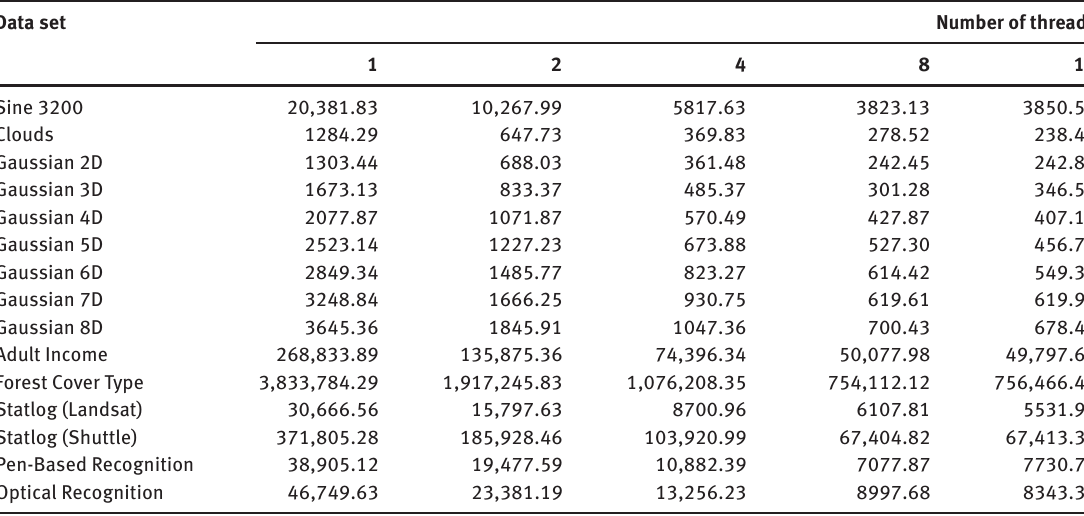
Table 2: Execution Time, in Milliseconds, of the Serial and the Parallel FMCOV Generation Algorithms. Data set